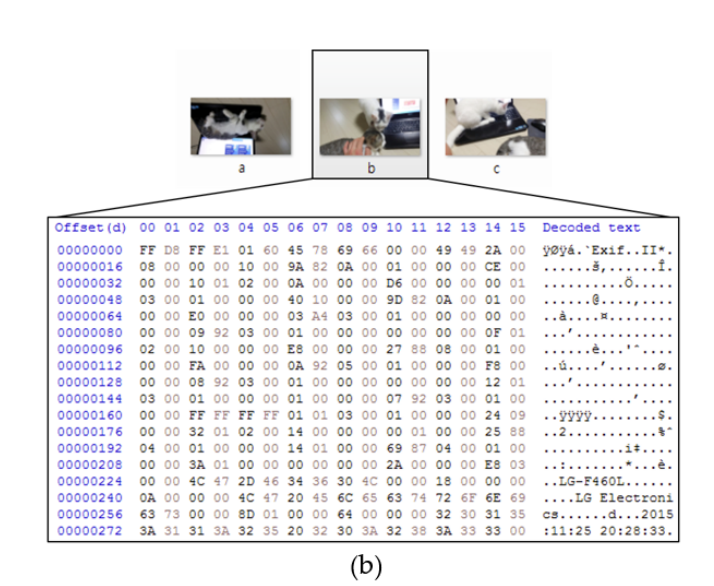
Figure 7. ( a ) Encrypted files ( b ) Decrypted files after applying our proposed